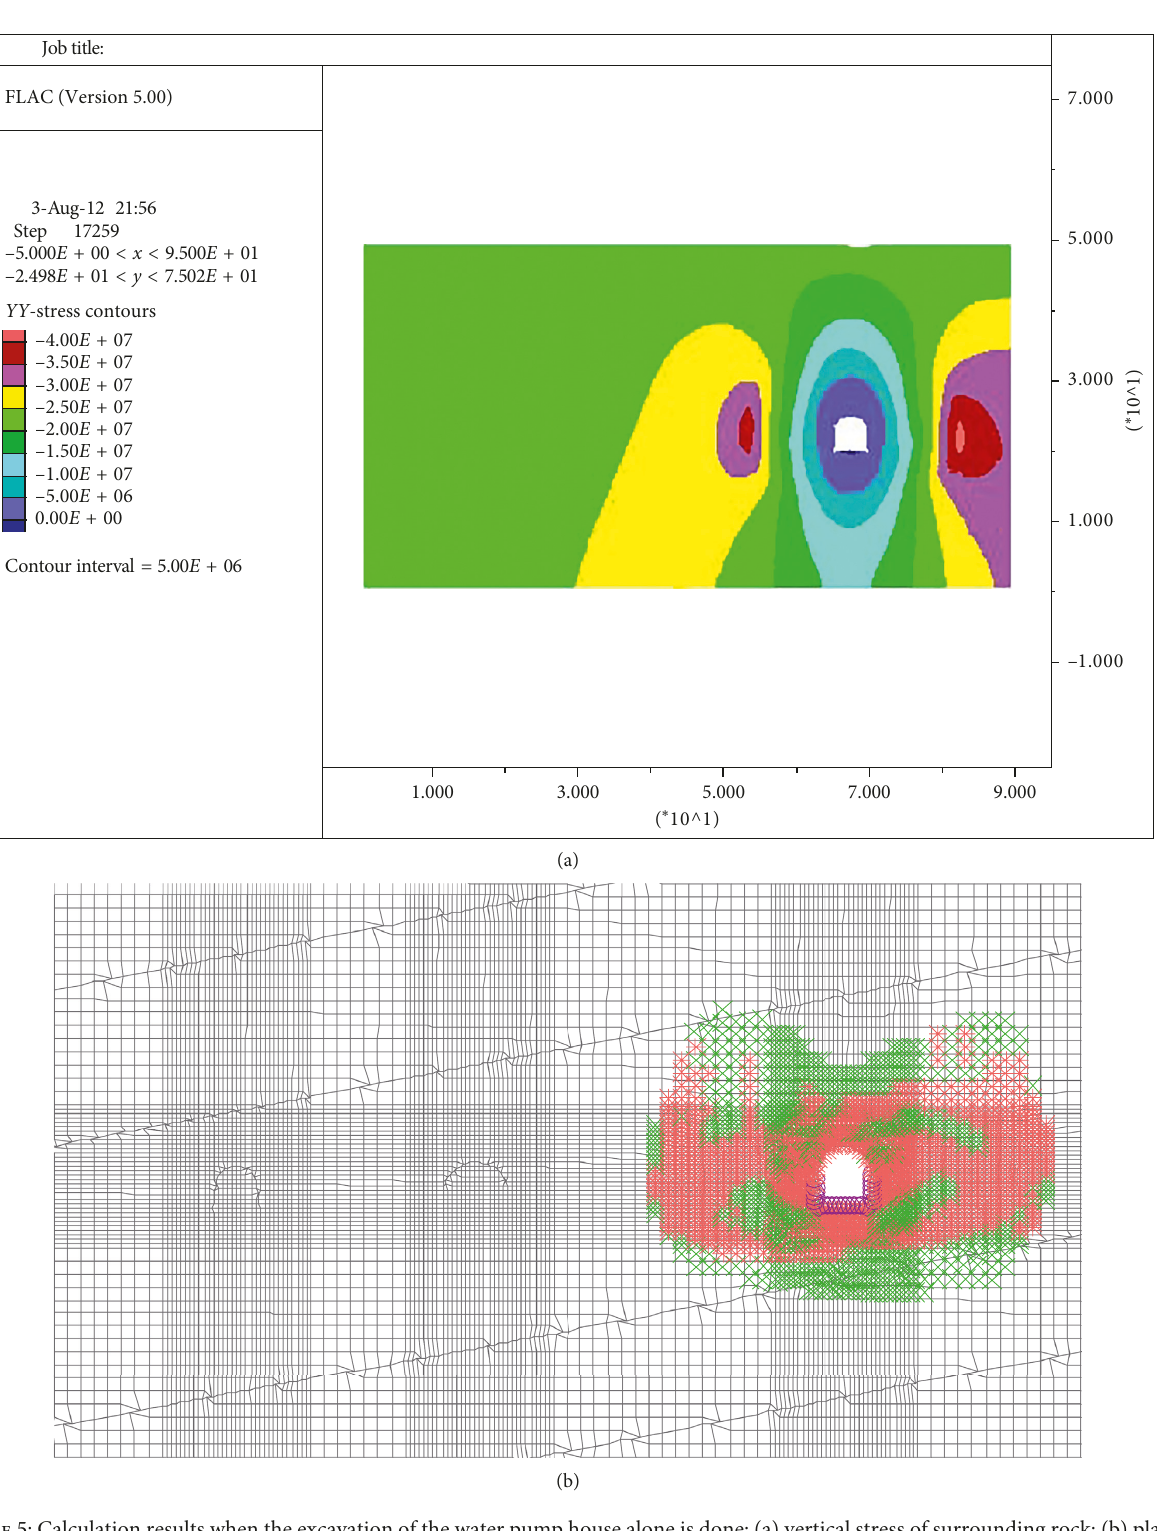
Figure 5: Calculation results when the excavation of the water pump house alone is done: (a) vertical stress of surrounding rock; (b) plastic zone of surrounding